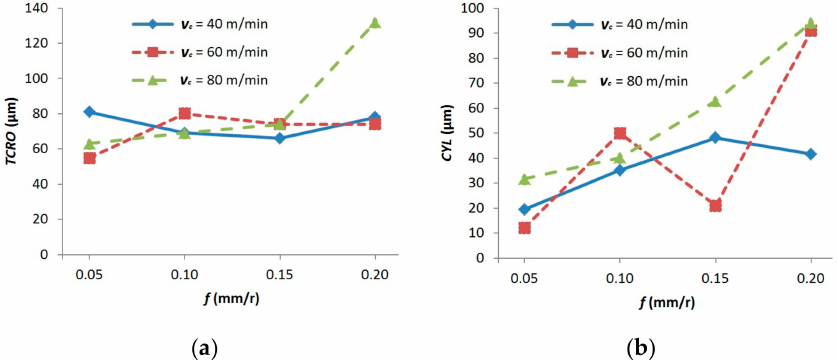
Figure 14. Mean deviations values as a function of v c and f for the ( a ) total circular run-out, and ( b )